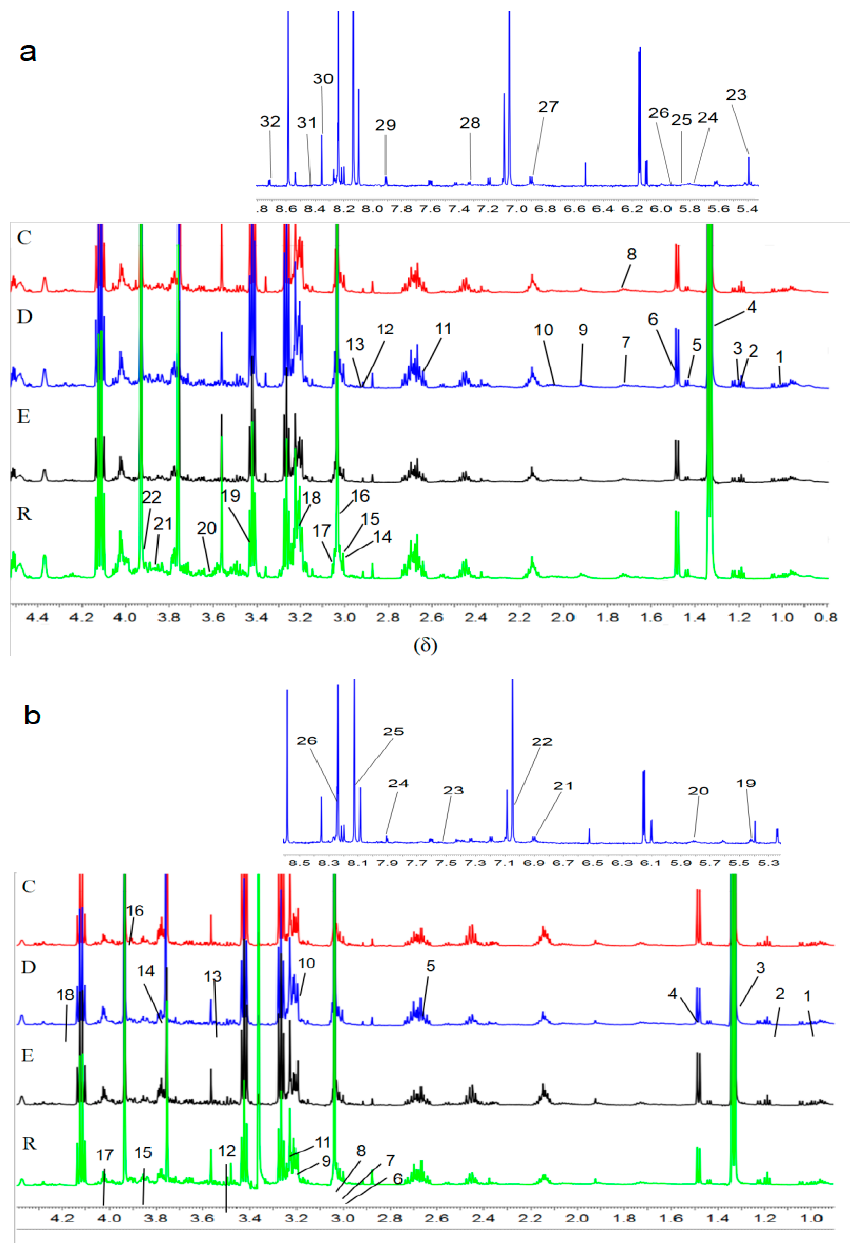
Figure 3. 1 H-NMR metabolite spectra ( δ ) of the gastrocnemius muscle ( a ) and soleus muscle ( b ).